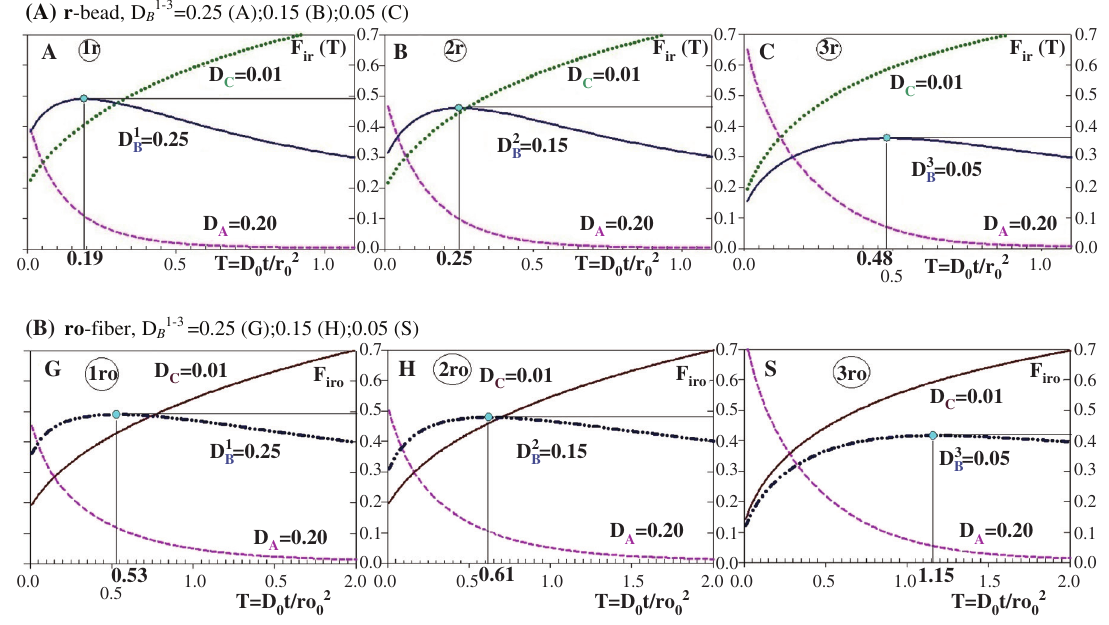
= 0.19 (A), 0.25 (B), 0.48 (C); ro -fiber ( b , 1ro-3ro). 2 mr (T) 2 r,ro